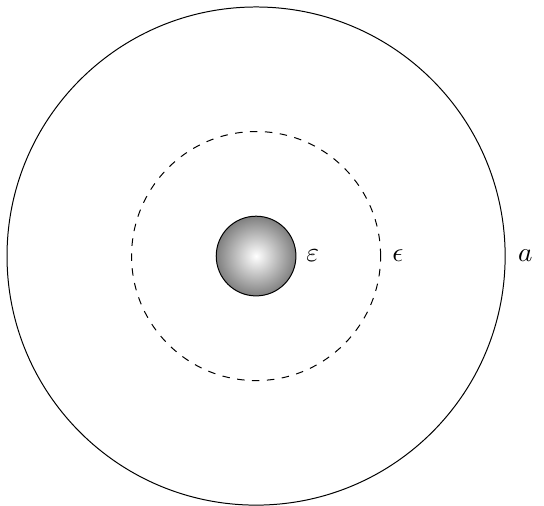
Figure 1 . A schematic of the scales arising in the boundary conditions near the source. We denote by " the actual UV physics scale associated with the underlying size of the source (e.g., the size of the proton), which by assumption is very small compared to the scale a of physical interest